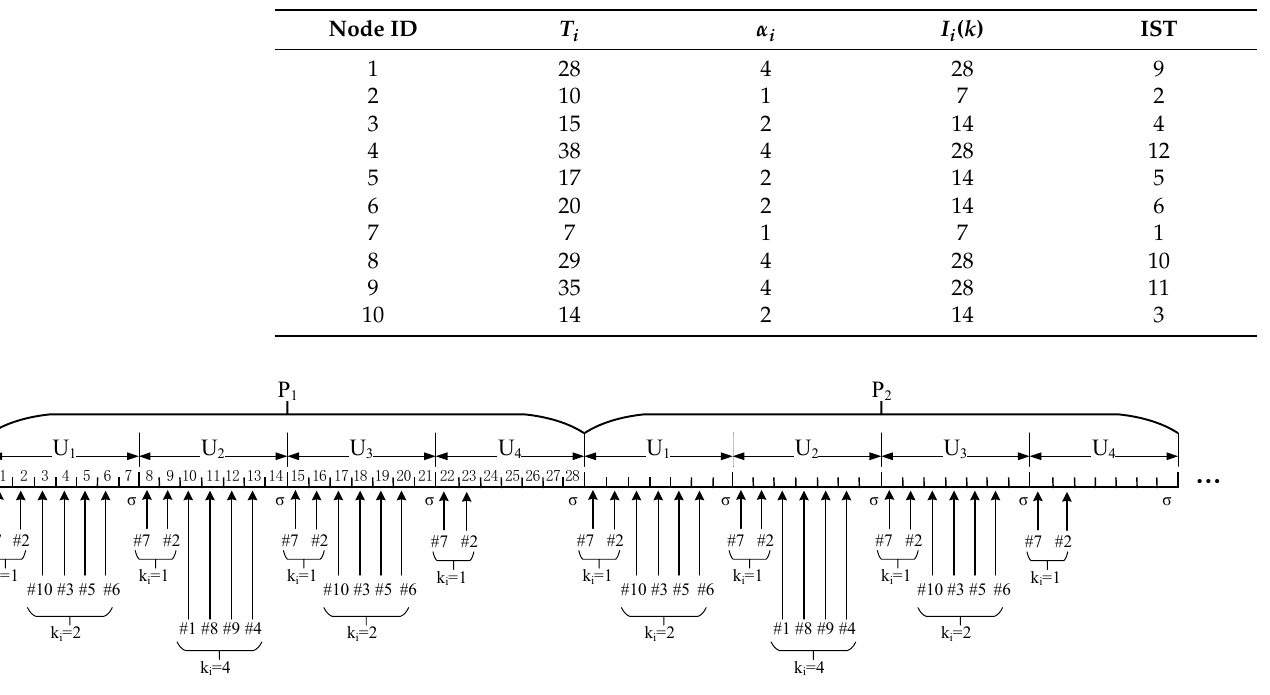
Table 2. Parameters setting of the example network.